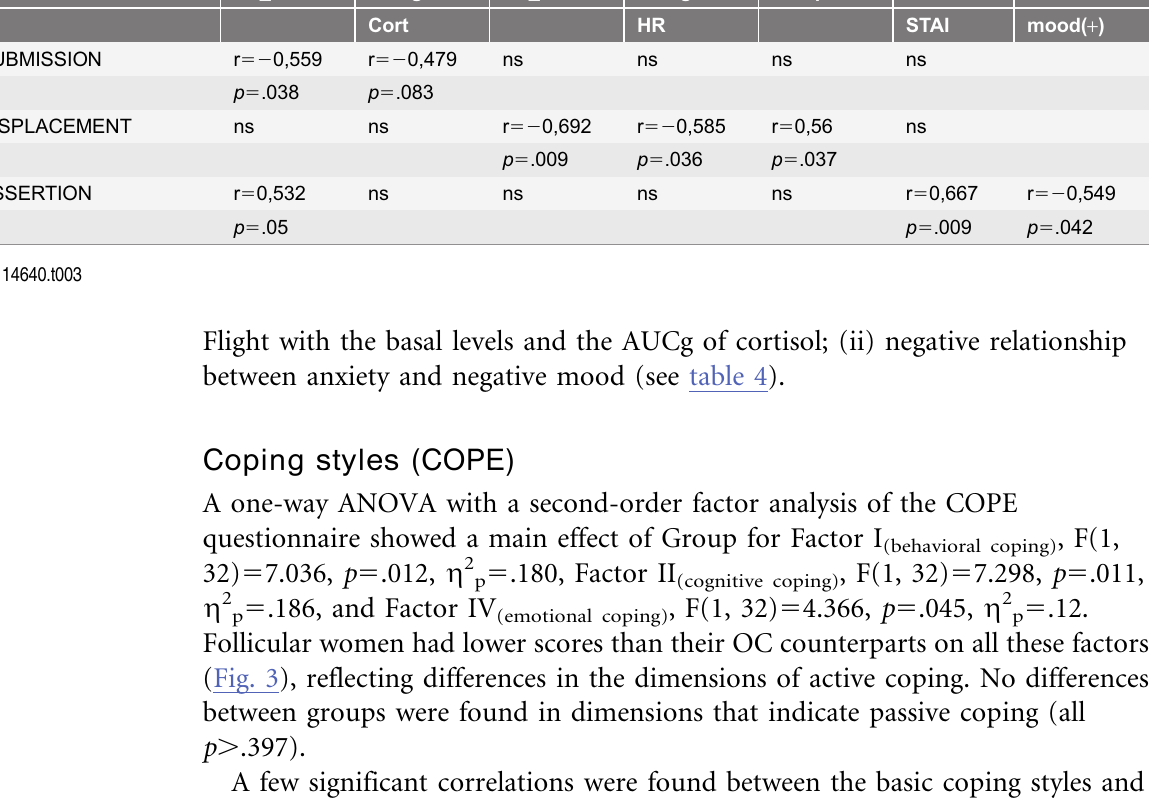
Table 3. Pearson correlations between psychophysiological basal levels, AUCg of cortisol and HR, anxiety and mood reactivity with the behavioral patterns performed during the speaking task of the TSST (data from women in the follicular group).